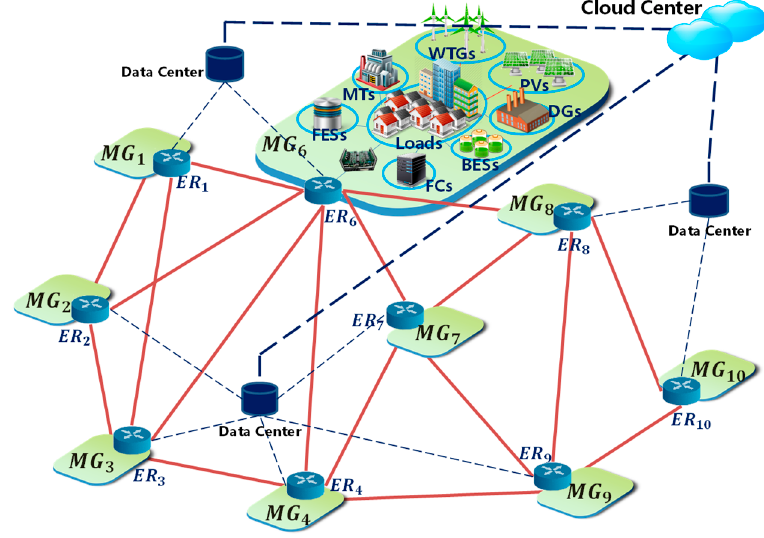
Figure 1. The studied energy internet (EI) scenario.